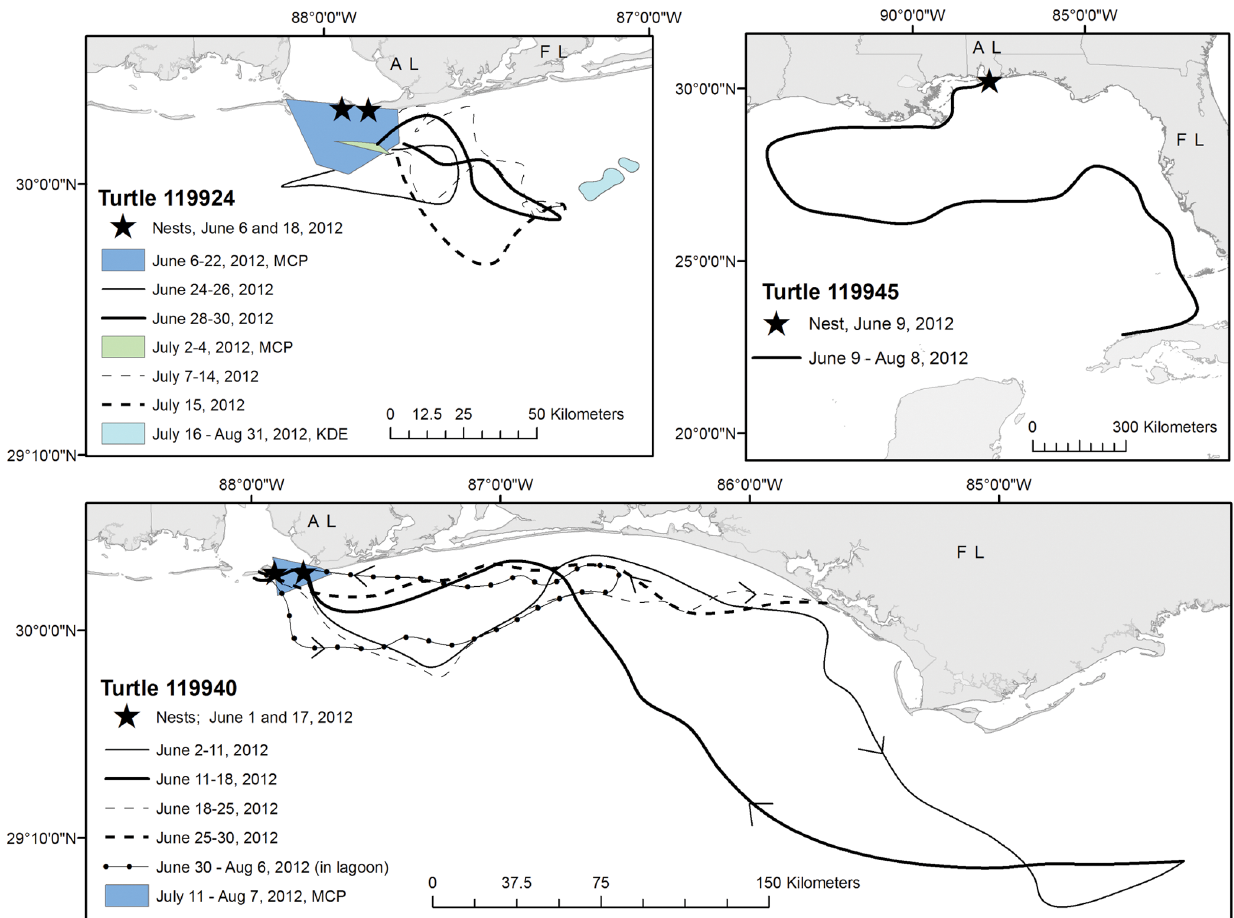
Figure 4. Examples of 3 different types of behavior for loggerhead sea turtles ( Carettacaretta ) in the Northern Gulf of Mexico, USA, during the inter-nesting period. Turtle 119924 displayed site-fidelity and selected a discrete habitat during inter-nesting periods; turtle 119945 wandered during inter-nesting, and did not return to land after nesting on 9 June 2012; turtle 119940 displayed nest-site fidelity but not site-fidelity to any in-water habitat during